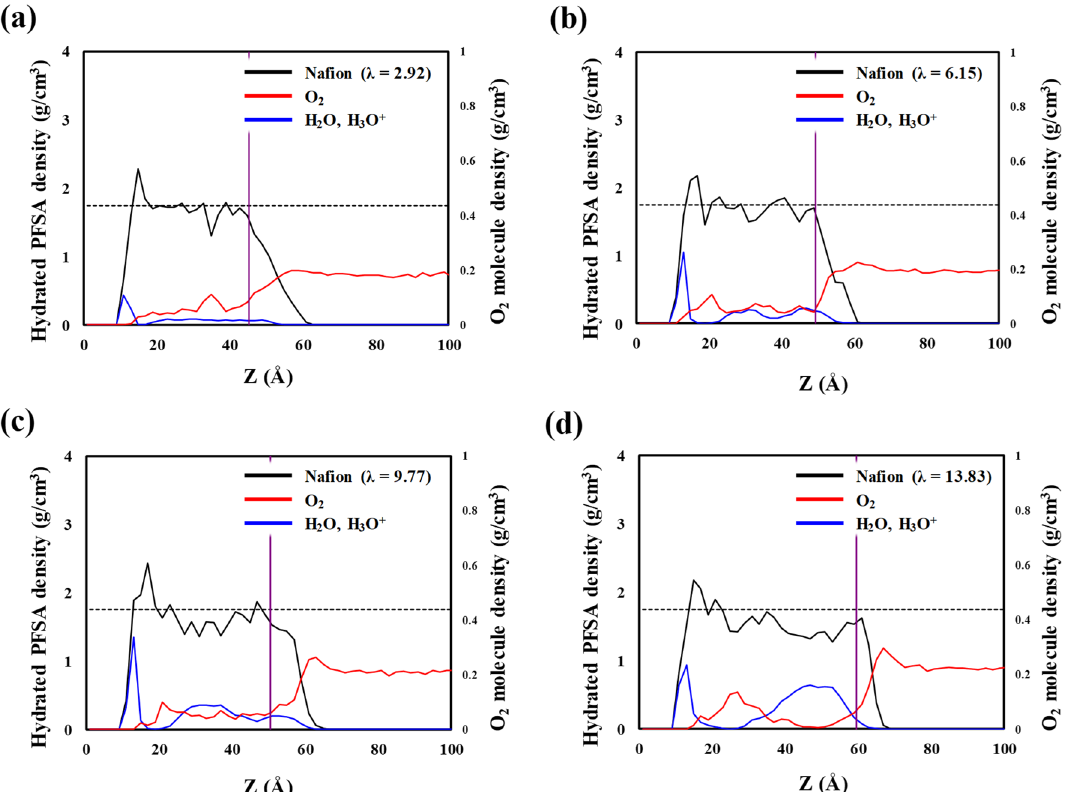
Figure 4. Density distributions of hydrated Nafion ionomer (with included water and hydronium ions; black lines), water and hydronium ions (blue lines), and O 2 molecules (red lines) on the Pt (111) surface along the thickness direction, with λ values of ( a ) 2.92, ( b ) 6.15, ( c ) 9.77, and ( d ) 13.83. Dashed lines show the previously reported density for hydrated bulk Nafion 20 . The purple line indicates the point of O 2 solvation occurs from the interface of gas/hydrated